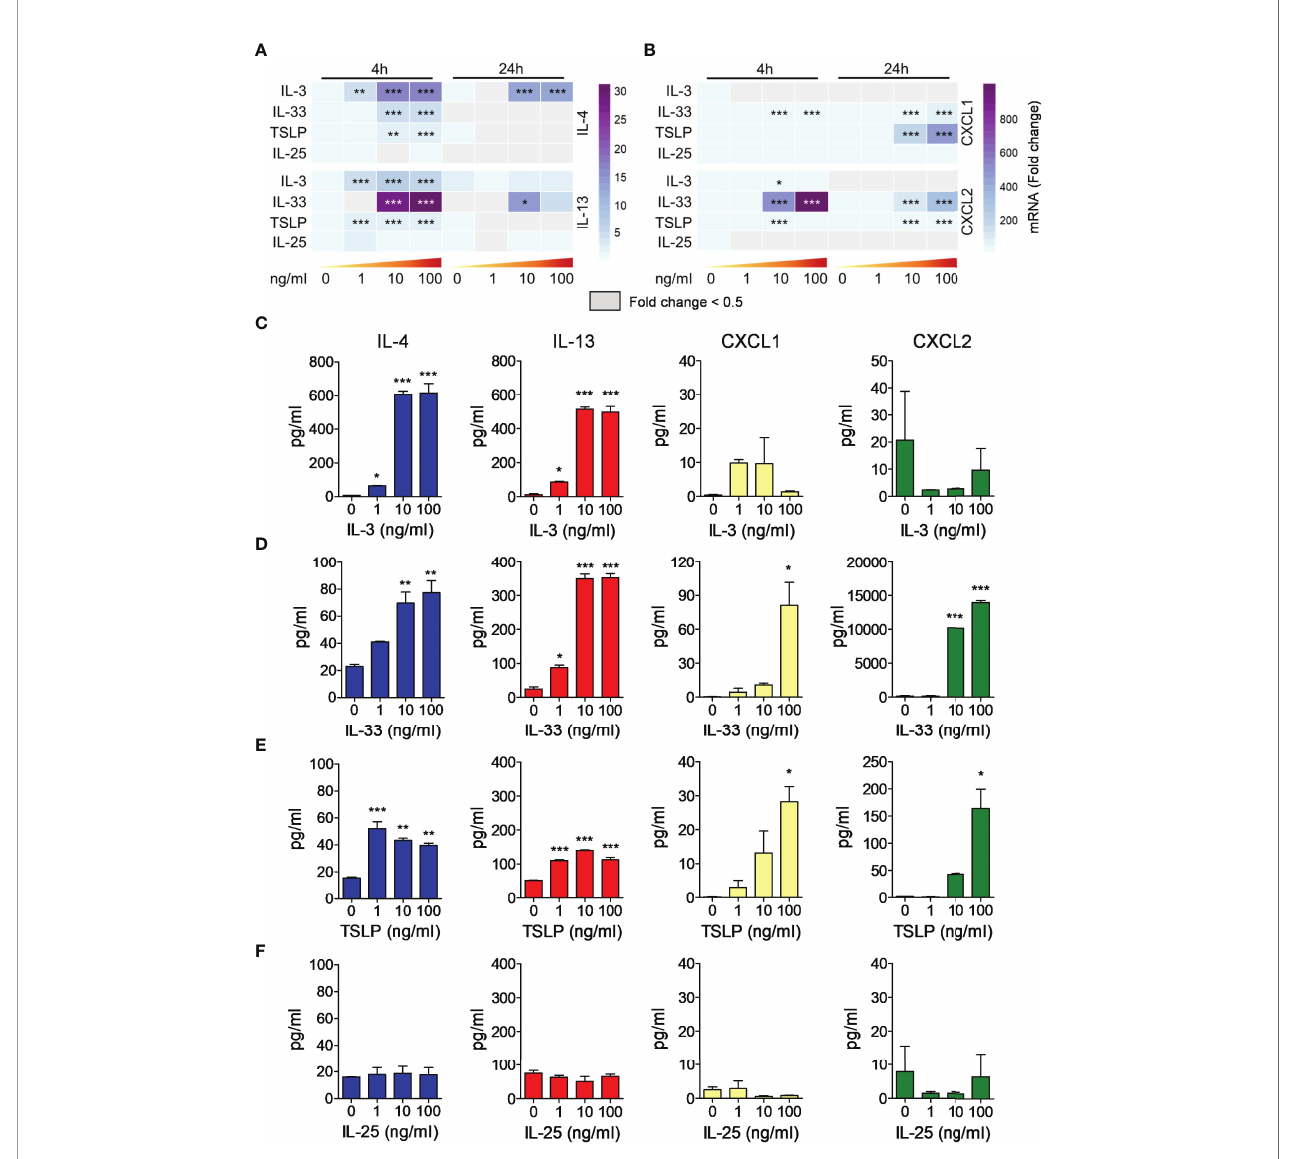
FIGURE 3 | Effects of rmIL-3, rmIL-33, rmTSLP, or rmIL-25 on cytokine (IL-4, IL-13) and chemokine (CXCL1, CXCL2) mRNA expression and protein release by mBaso. Puri fi ed mBaso (10 6 cells/ml) were stimulated with the indicated concentrations of rmIL-3, rmIL-33, rmTSLP, or rmIL-25. Expression of IL-4 and IL-13 (A) , CXCL1 and CXCL2 (B) mRNAs after 4 and 24 hours of stimulation was assessed by qRT-PCR. Data in heatmap represent the mean fold increase of mRNA normalized to HPRT and with respect to untreated (NT) controls at 4 h +/- SD. Concentrations of IL-4, IL-13, CXCL1 and CXCL2 in culture supernatants of mBaso incubated (24 hours at 37°C) with the indicated concentrations of rmIL-3 (C) , rmIL-33 (D) , rmTSLP (E) , or rmIL-25 (F) were measured by ELISA. Data represent the mean amount of released cytokines +/- SD in culture triplicates. One representative experiment out of at least three replicates is shown. * p < 0.05; ** p < 0.01; *** p <